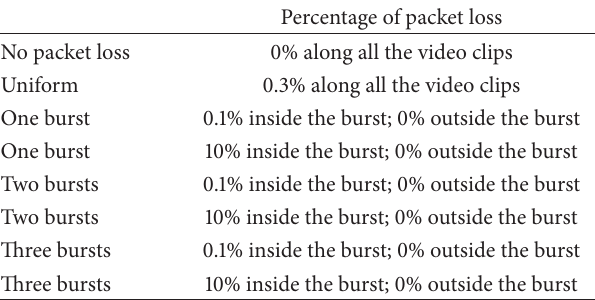
Table 1: Packet loss patterns